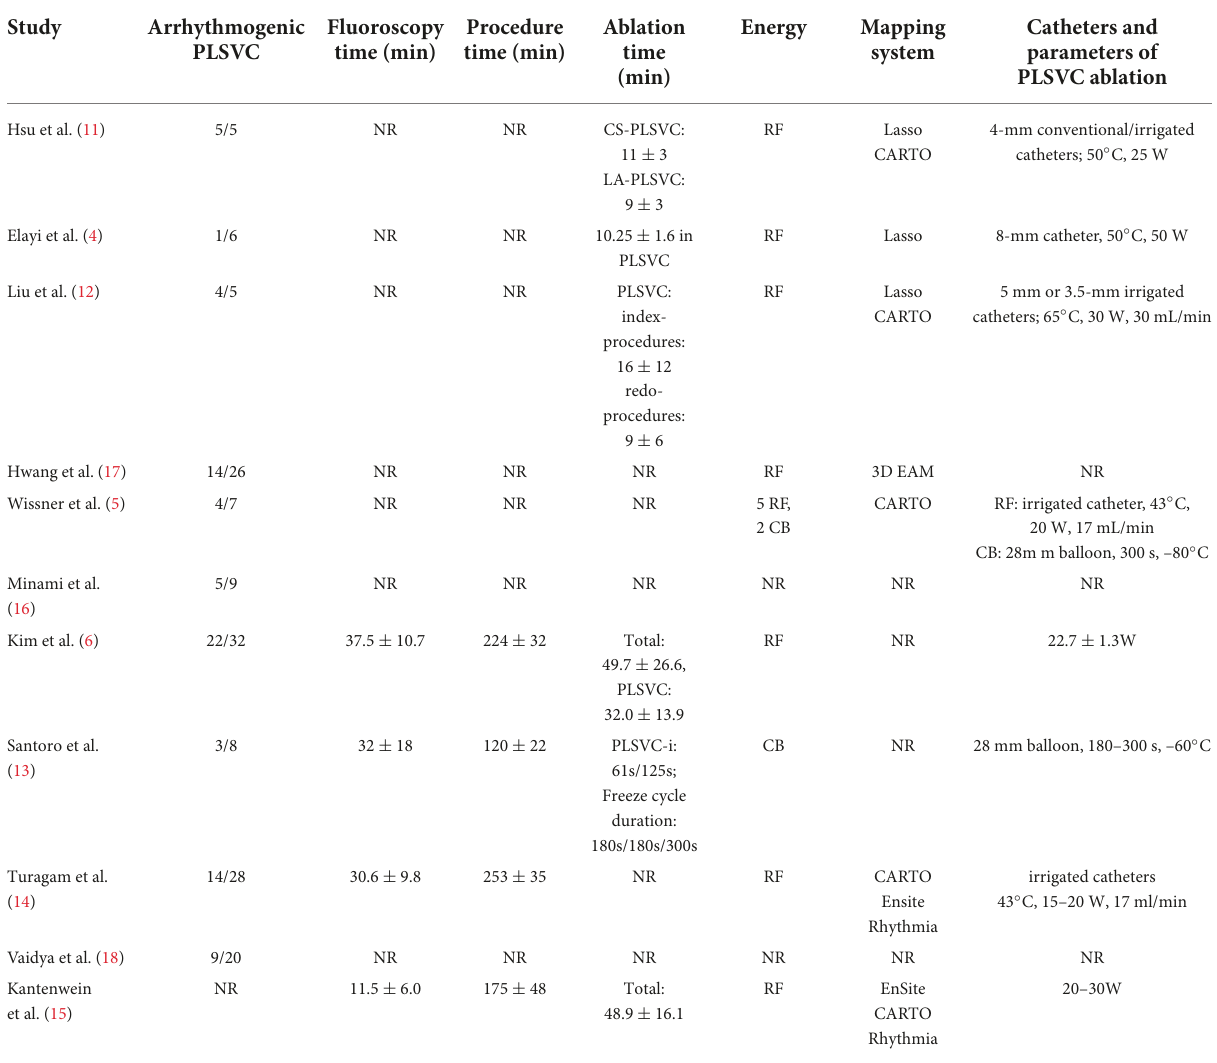
TABLE 3 Procedural